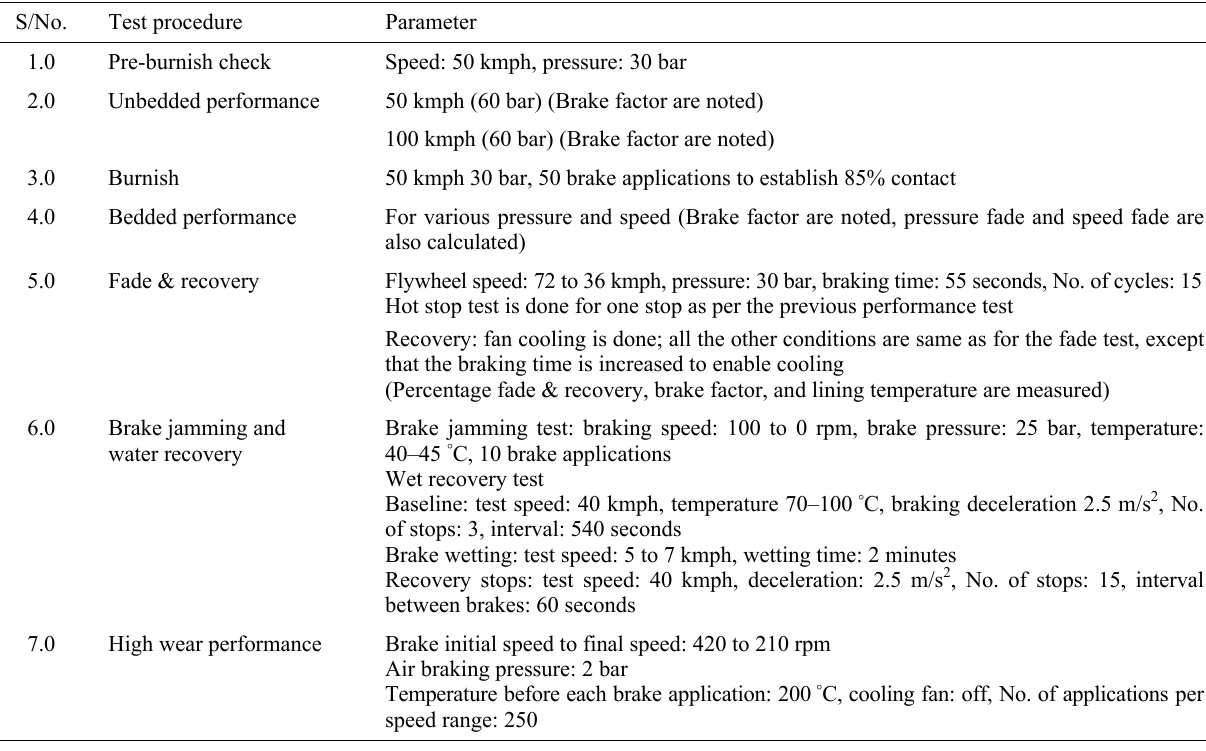
Table 2 Test procedure of the full-scale inertia brake dynamometer (customized schedule).